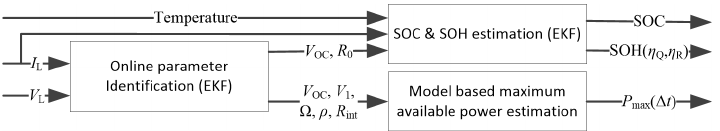
Figure 3. Model layout with the topology of the